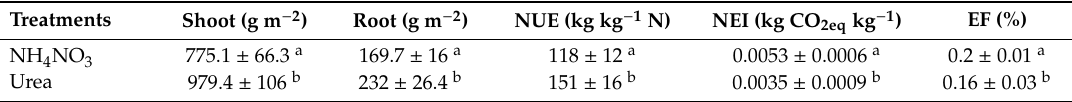
Table 4. Shoot biomass, root biomass, nitrogen use efficiency (NUE), nitrous oxide emission intensity (NEI), and emission factor (EF) in ammonium nitrate plots and urea plots. Data are means ( n = 4) ± SE. Treatments